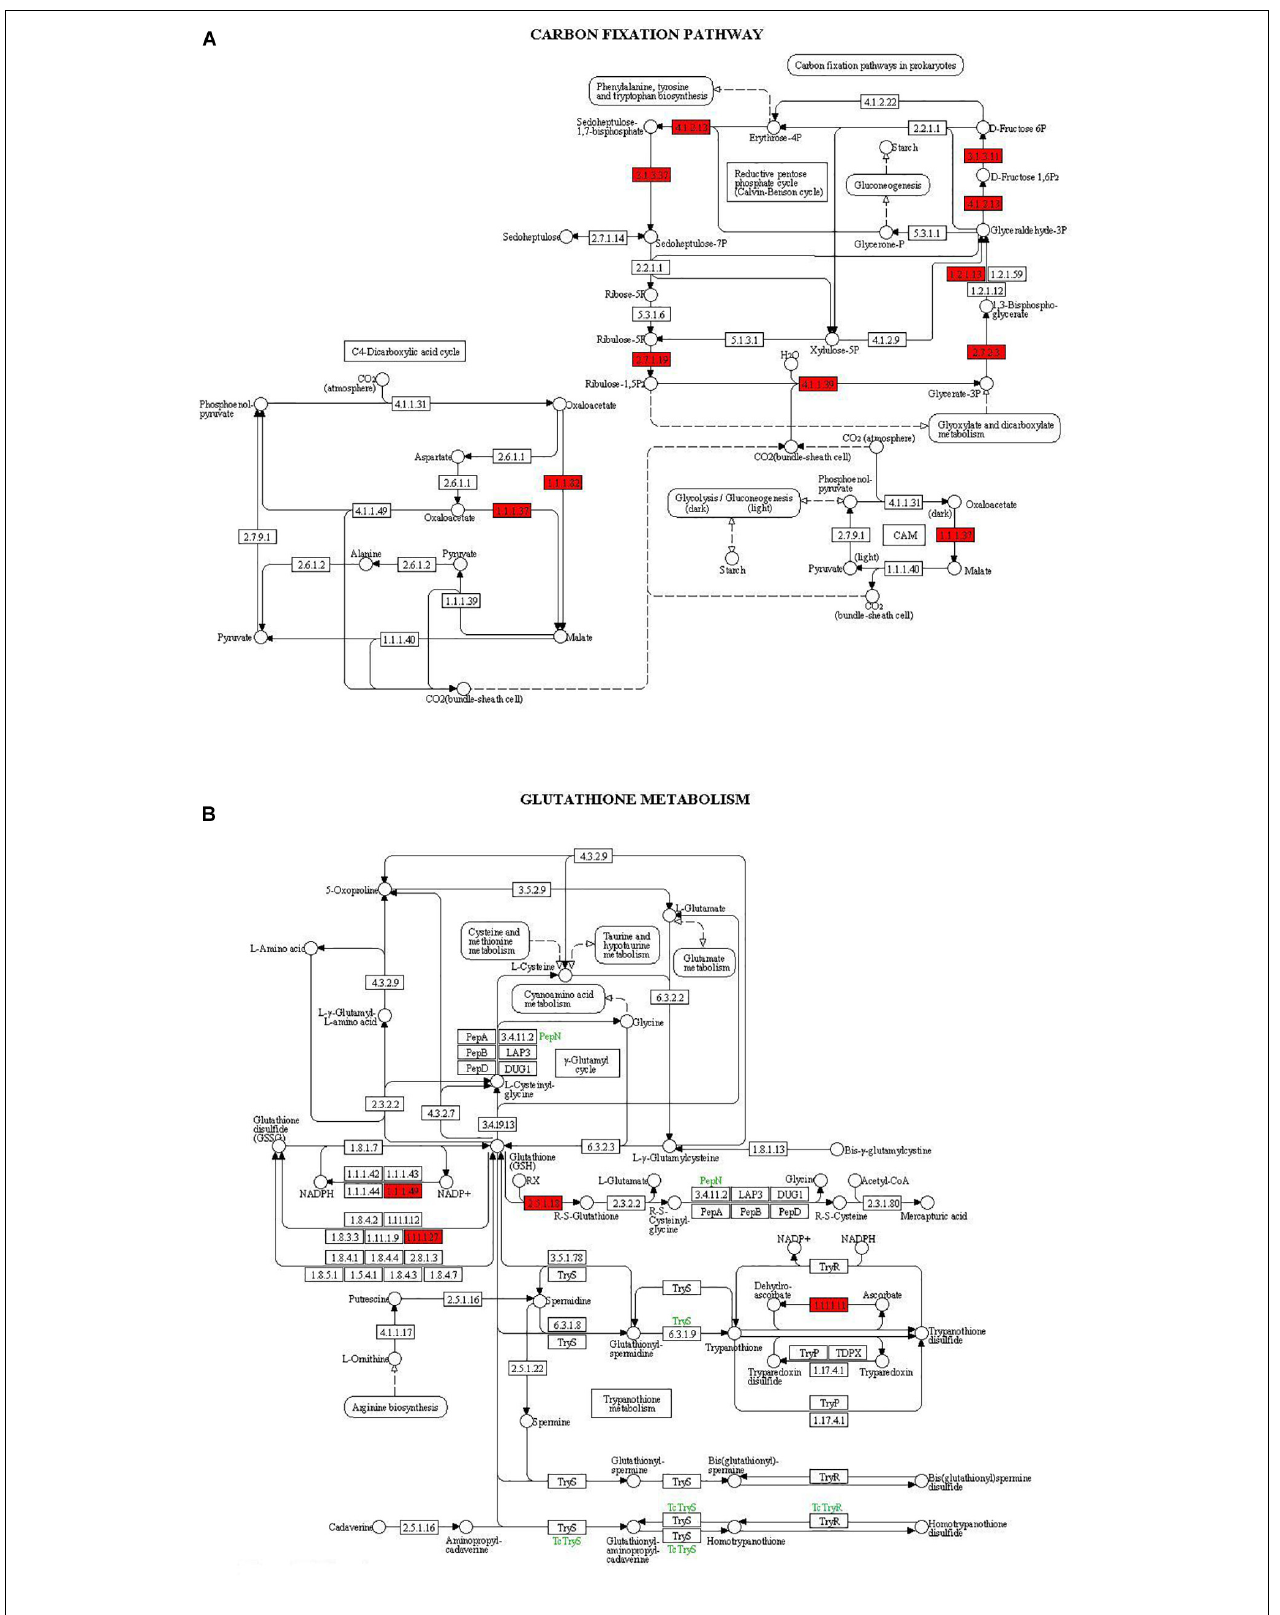
FIGURE 6 | Cotinued